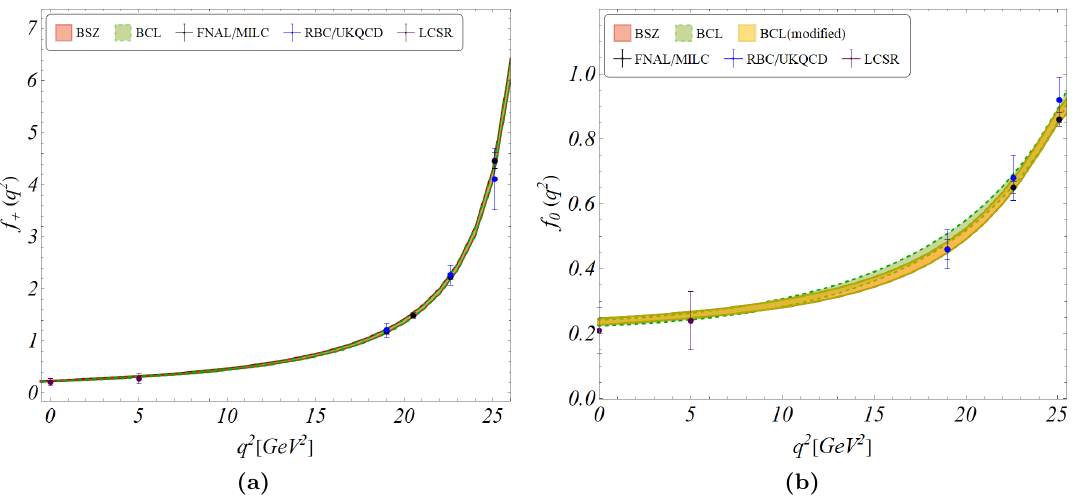
Figure 4 . Comparison of q 2 distributions of the form factors extracted in BSZ and BCL parametrizations. The lattice points and the LCSR pseudo data points at q 2 = 0 and 5 GeV 2 are also shown in the